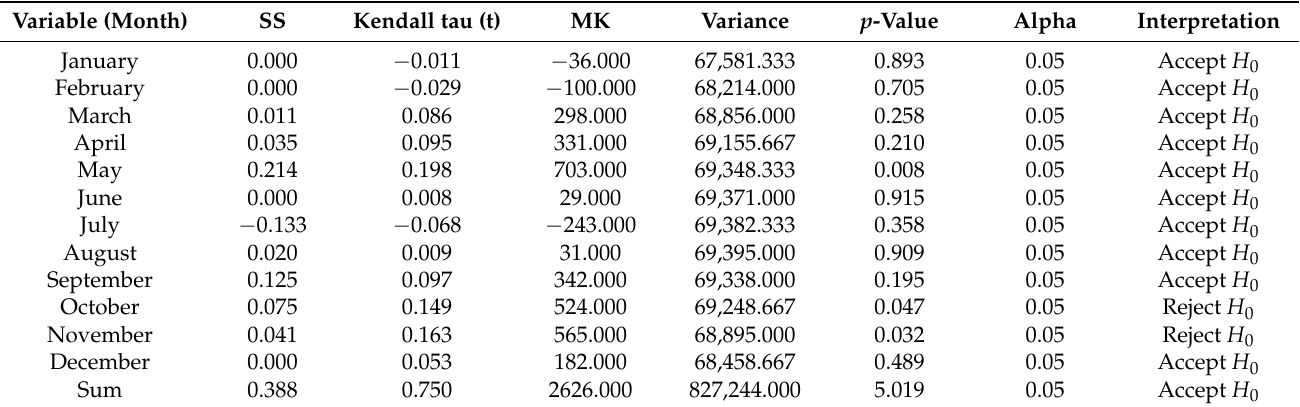
Table 2. SS and MK test results for the Kyakhta